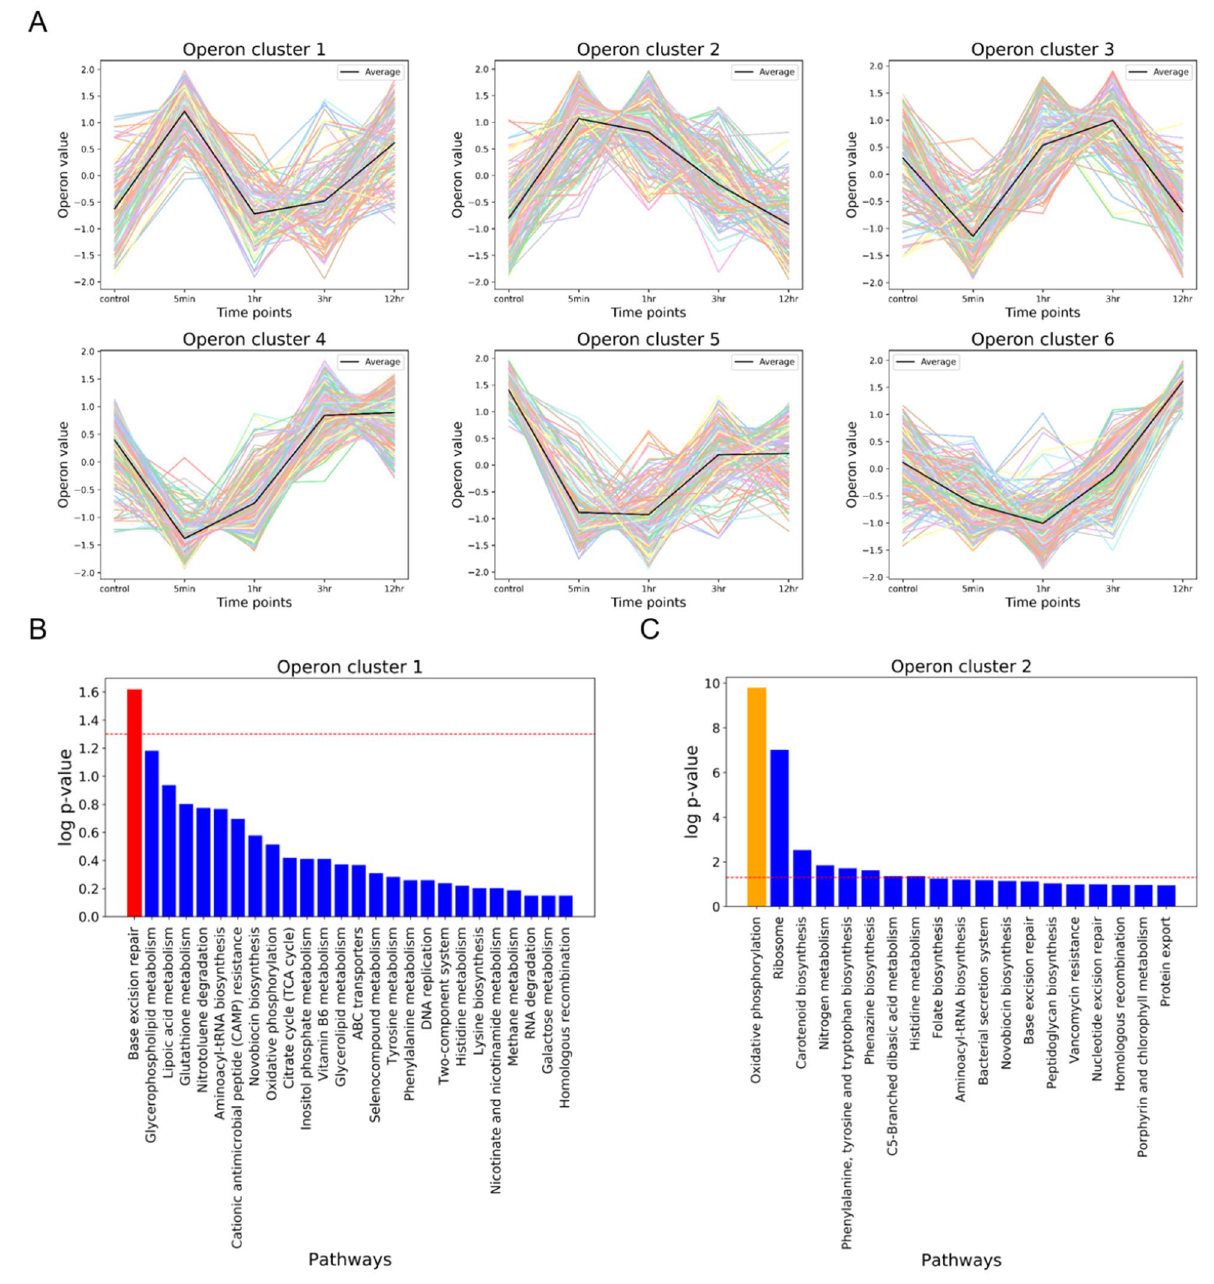
Figure 6. Operon prediction and analysis. ( A ) Six operon clusters were identified with k-means clustering method. Black colored line is the average of the operon values that belonging to the cluster at the each time points. ( B , C ) Pathway enrichment analysis of genes in operon cluster 1 and 2. Red colored bar is most enriched term in cluster1 and orange colored bar is most enriched term in cluster2. The red dotted line indicates statistical significance of p